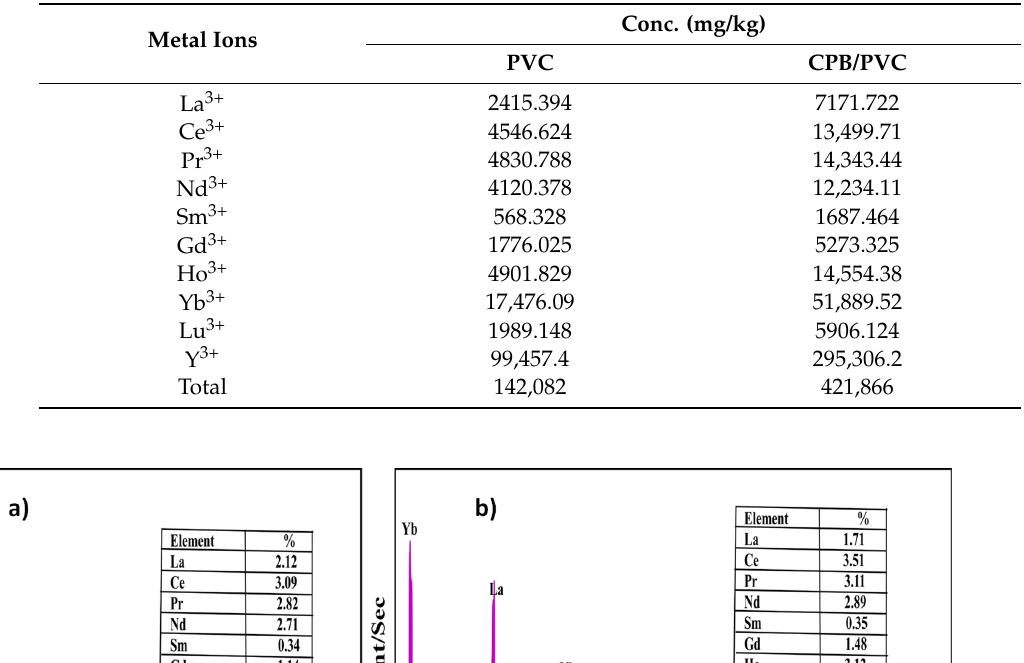
Table 8. Chemical analysis of RE oxalate products obtained from REEs loaded on two sorbents using ICP-OES.